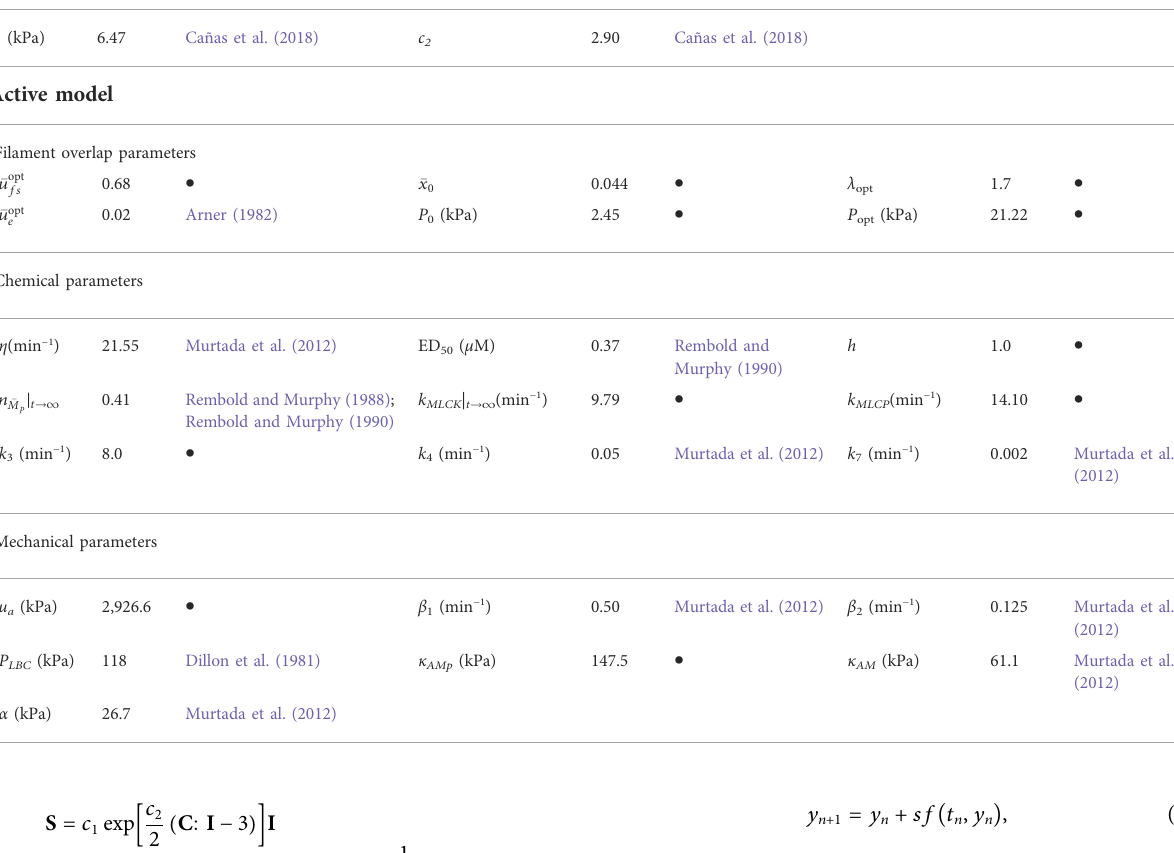
TABLE 1 Parameters of the mechanochemical model. Symbol (cid:129) denotes the paramaters determined in this study. Passive